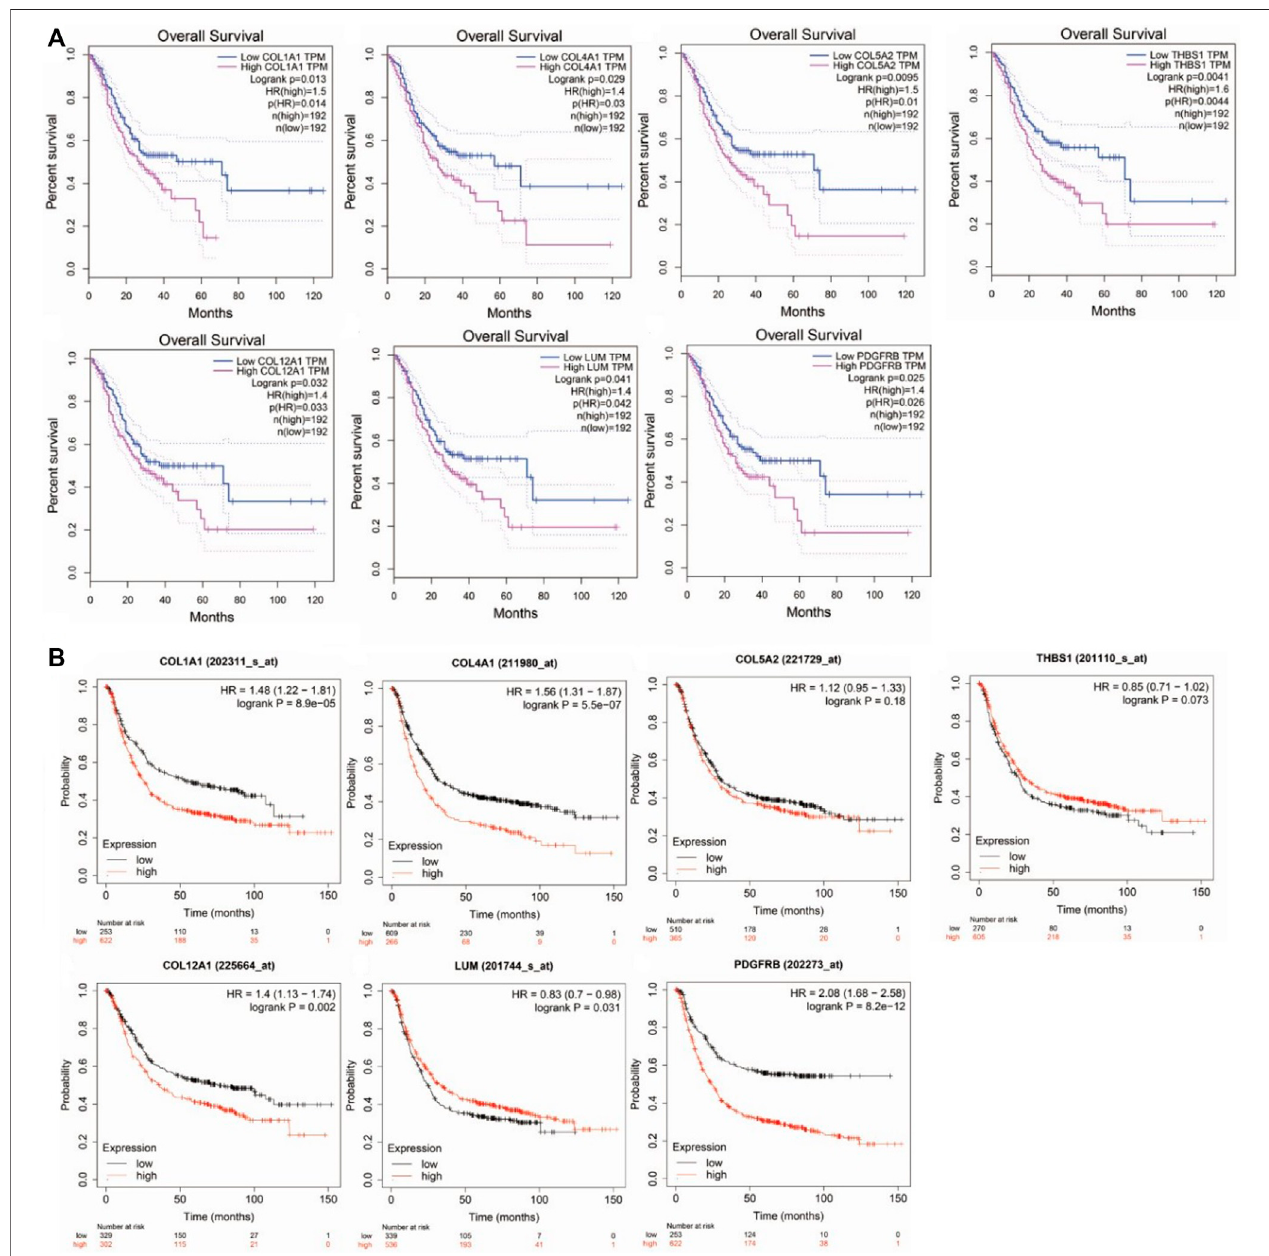
FIGURE 4 | Survival analysis of hub genes in Gastric cancer. (A) . by GEPIA using TCGA datasets. (B) . by KM-plotter using microarray datasets.